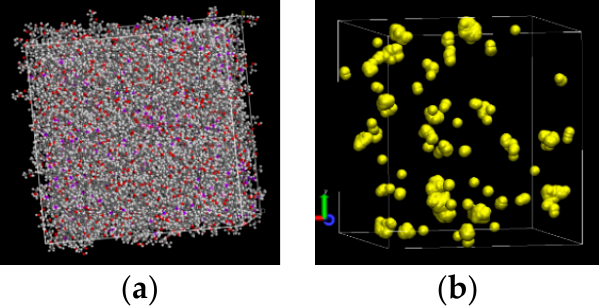
Figure 4. Renderings of a cell with atoms ( a ) and the corresponding probe spheres occupying free space ( b ).